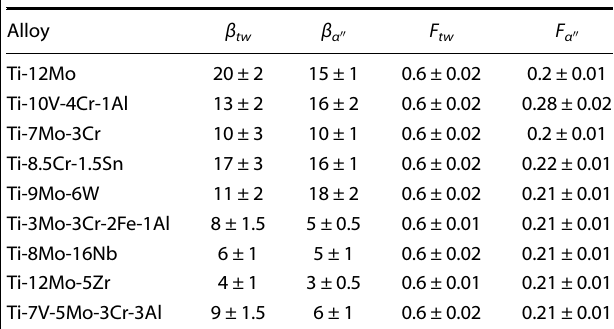
β tw the twinning kinetics parameter and martensitic transformation; F tw and F α ″ the saturation volume fractions of twin and martensite,